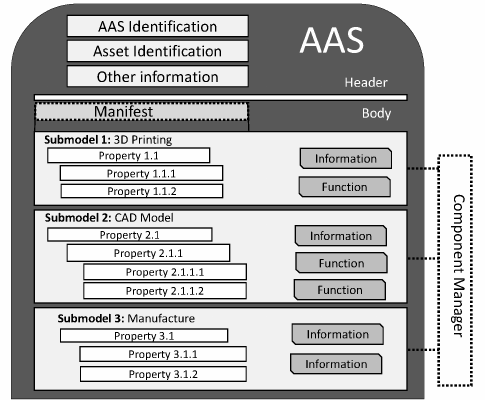
Figure 16. AAS metamodel for a 3D